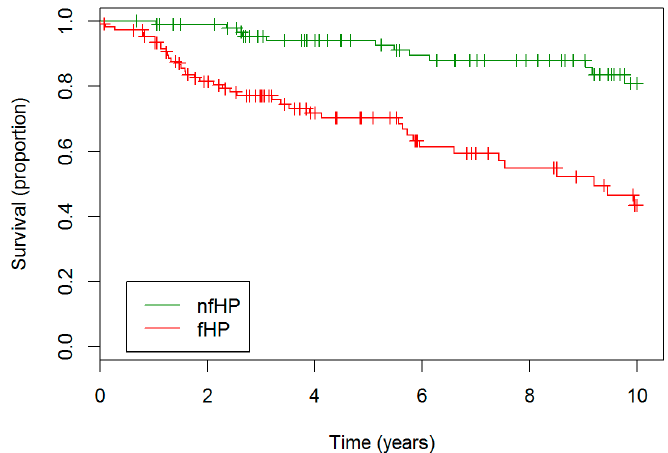
Figure 1. Survival nfHP and fHP patients. fHP patients experienced a worse outcome compared to nfHP patients. Definition of abbreviation: nfHP, non-fibrotic hypersensitivity pneumonitis, fHP, fibrotic chronic hypersensitivity pneumonitis